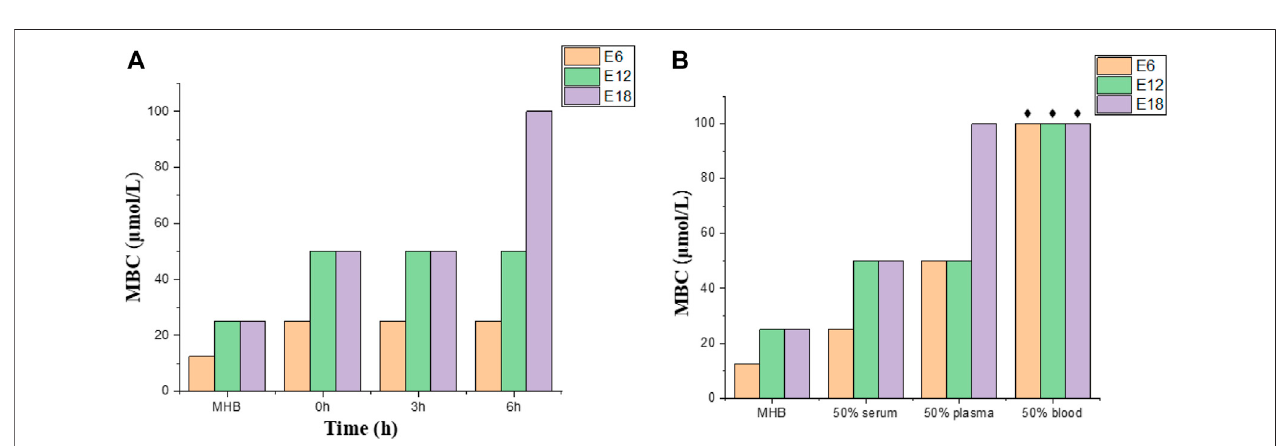
FIGURE4| Plasmastability andbactericidalactivityincomplexmammalian fl uids. (A) Conjugates(E6,E12,E18)against E.coli inplasmatreatedat differenttimes. (B) Conjugates (E6, E12, E18) against E. coli in different culture mediums (50% serum, 50% plasma and 50% blood). The black star represents > 100 μ mol/L.